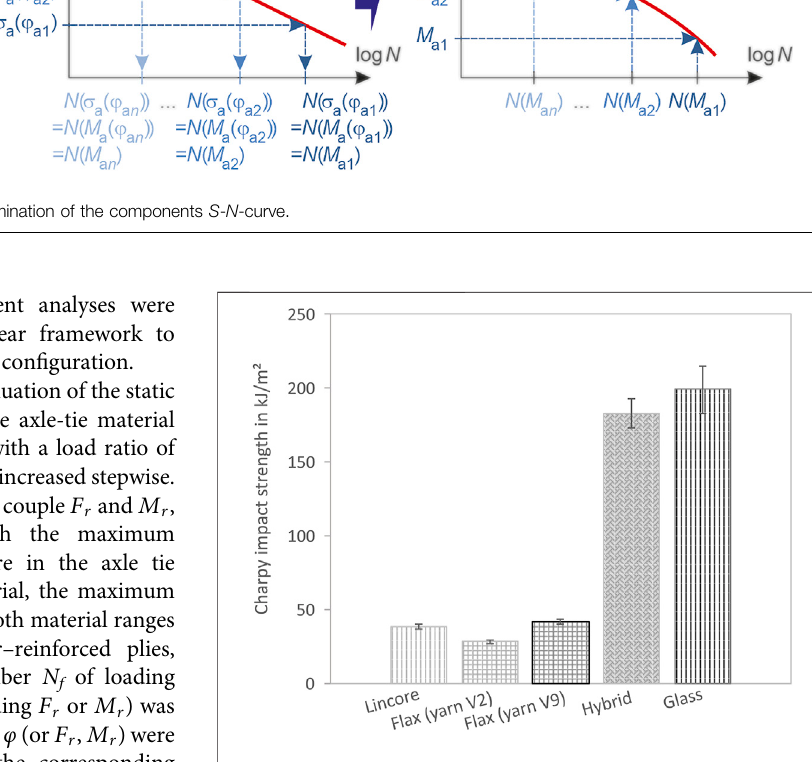
FIGURE 4 | Unnotched Charpy impact strength of composite laminates (mean value ± standard